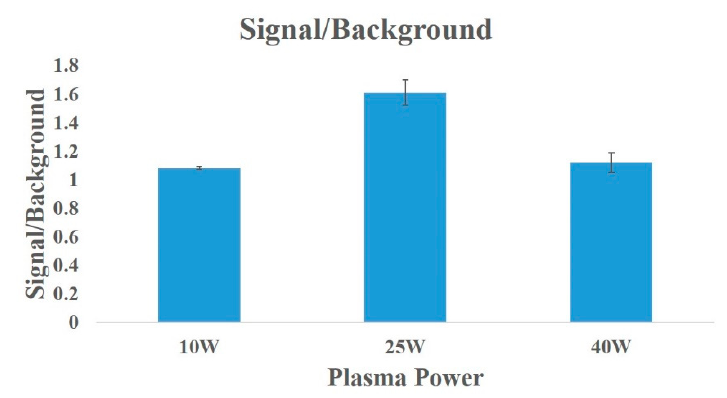
Figure 1. Signal-to-background ratio of surface functionalized fiber prepared with increasing plasma power. Signal-to-background ratio was obtained by dividing the fluorescence counts from the functionalized fiber exposed to aluminium ions vs the functionalized fiber by itself.